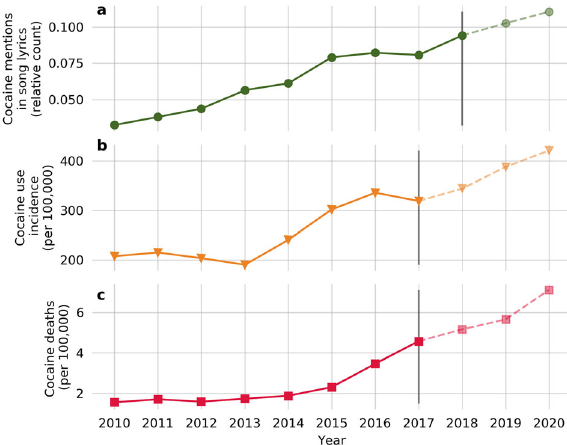
Fig. 2 Cocaine use and cocaine-related death rates for 2018, 2019, and 2020. a Projection of cocaine mentions in song lyrics for 2019 and 2020. b Projection of cocaine use incidence for 2018, 2019, and 2020. c Projection of cocaine mortality for 2018, 2019, and 2020. Predictive models were fi tted with lyrics and epidemiological data from 2000 to 2018 and assumed linear growth of cocaine mentions in song lyrics.